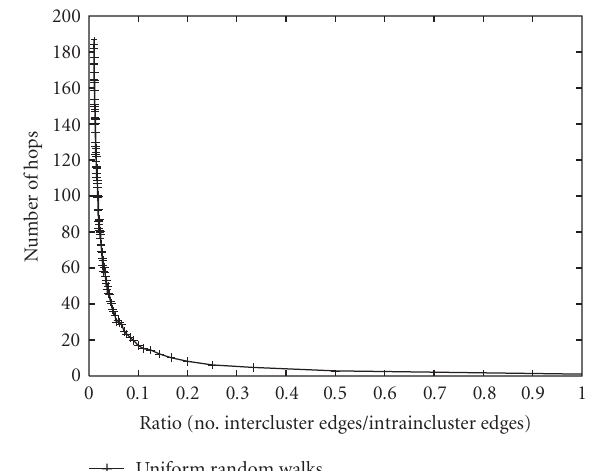
Figure 1: The number of hops of random walks escaping out of the cluster decreases exponentially with the ratio of number of inter- cluster edges to the number of intracluster